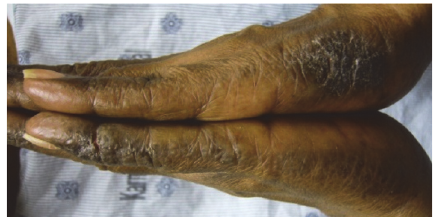
Figure 3: Acrokeratosis paraneoplastica . Xerotic scaling and exco- riations were present on the bilateral upper arms, lower legs, and lower back. The xerosis was accentuated on the lower legs with fine, polygonal